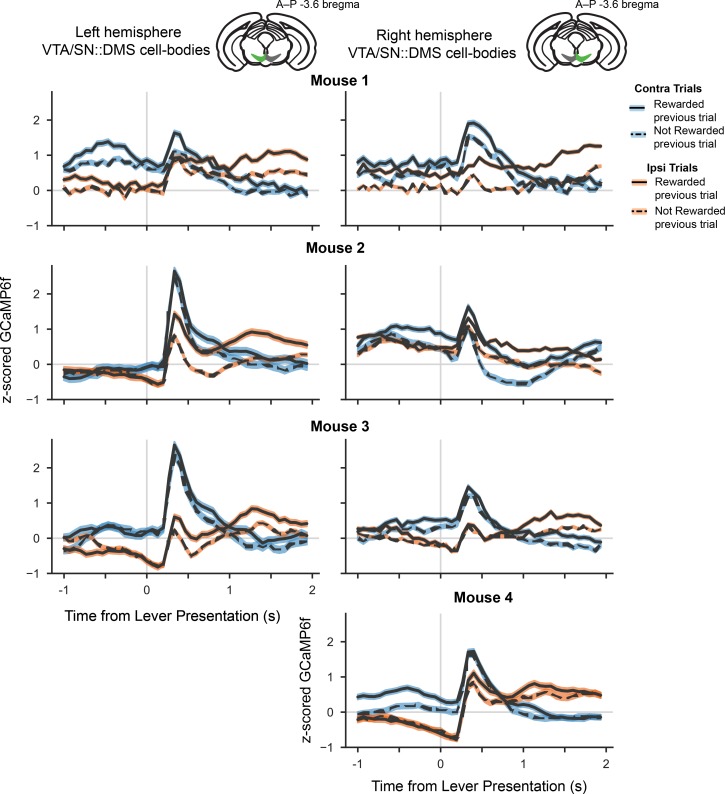
Averaged GCaMP6f signals of left and right hemispheres recordings from VTA/SN::DMS cell-bodies data (n = 4 mice, 7 recording sites).GCaMP6f signal relative to the lever presentation time for contralateral trials (blue) and ipsilateral trials (orange), as well as rewarded (solid) and non-rewarded previous trial (dotted) from VTA/SN::DMS terminals. Colored fringes represent ±1 standard error from activity averaged across trials. Each row represents averaged data from a distinct mouse (n = 4 total), with left and right column representing the left and right hemisphere recordings.